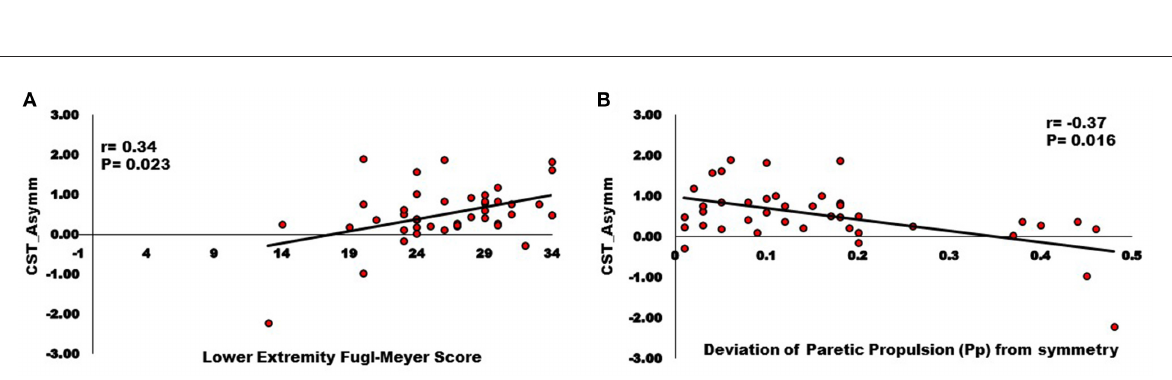
of CST streamlines (Figure 6). Specifically, stroke